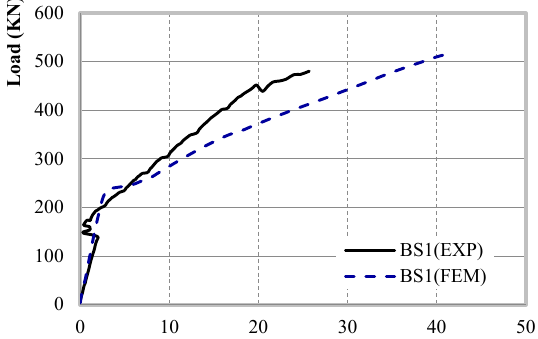
Figure 21. Load-deflection curve of BS1 slab.